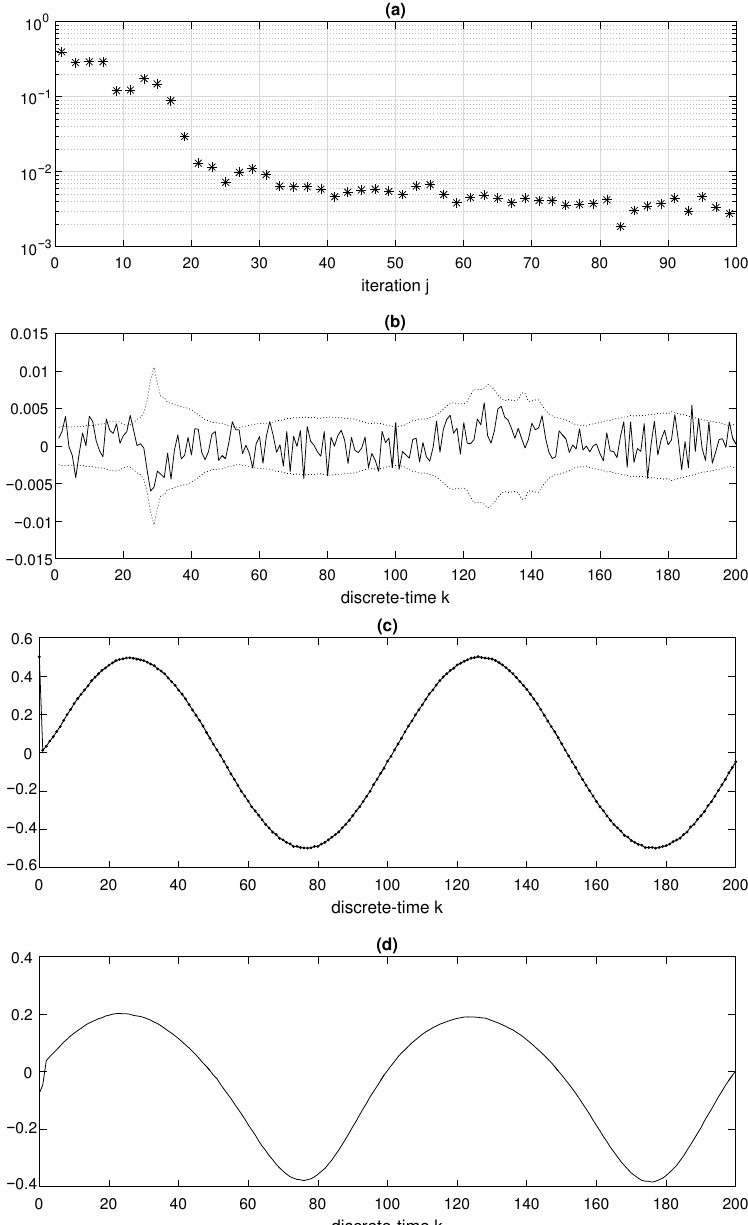
( k ) | ( ∗ ) versus iteration j . ( b ) e 100 ( k ) (solid line) and φ 100 ( k ) , − φ 100 ( k ) Figure 4. ( a ) max k ∈{ 1, ··· ,200 } | e j φ ( k ) (dotted line) versus discrete- (dotted lines) versus discrete-time k . ( c ) y 100 ( k ) (solid line) and y 100 d time k . ( d ) u 100 ( k ) versus discrete-time k